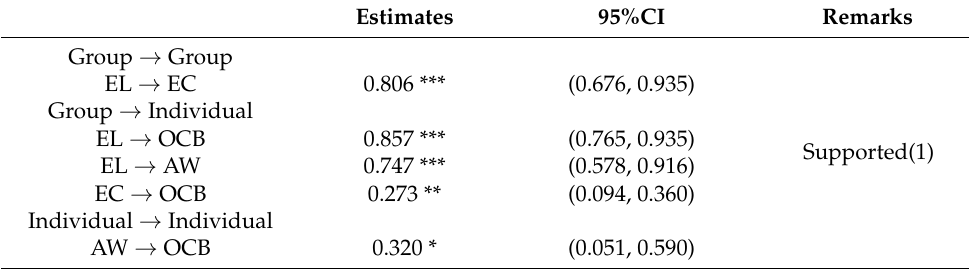
Table 3. Summary of direct